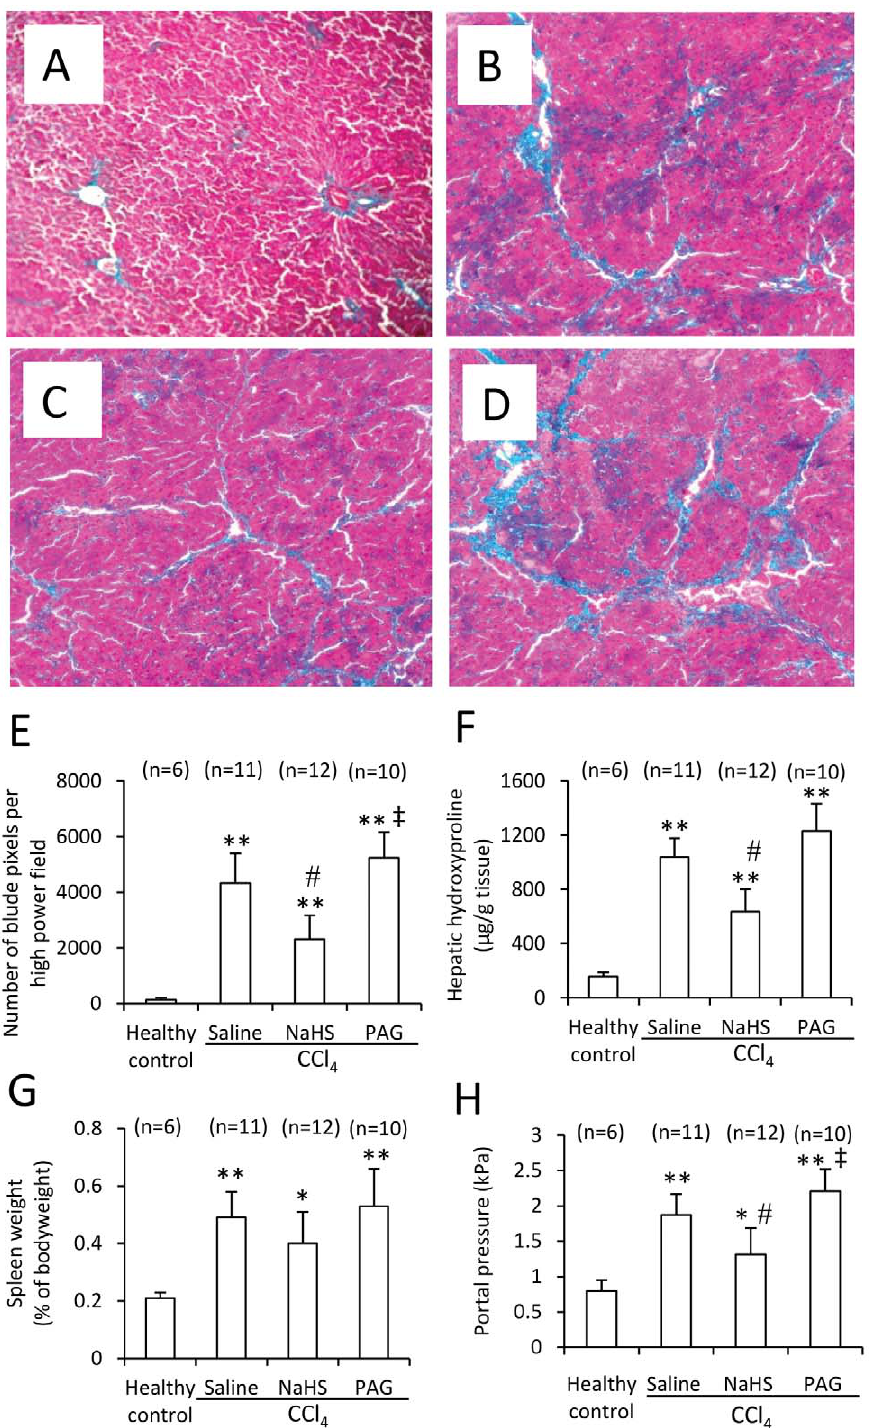
Figure 3. Histology of liver cirrhosis, hepatic hydroxyproline, spleen weight and portal pressure in the prevention experiment. Representative illustrations (200 6 magnification) of Masson-stained liver sections were taken from healthy controls (A), or rats treated with CCl 4 + saline (B), CCl 4 + NaHS (C) or CCl 4 + PAG (D), for 12 weeks. (E) The numbers of blue pixels of each image of the above Masson-stained liver sections were counted, and the average number of blue pixels for each liver was calculated. (F) The level of hydroxyproline in livers taken from the above rats was measured. (G) Each spleen was weighed as % of bodyweight. (H) The portal pressure of each was measured. Data were expressed mean 6 SD. n, number of samples. Compared to the healthy controls, a significant difference is denoted by ‘‘*’’, and a highly significant difference, by ‘‘**’’ (P , 0.001). Compared to saline + CCl 4 -treated rats, a significant increase is denoted by ‘‘ { ’’, and a significant reduction is denoted by ‘‘ # ’’.